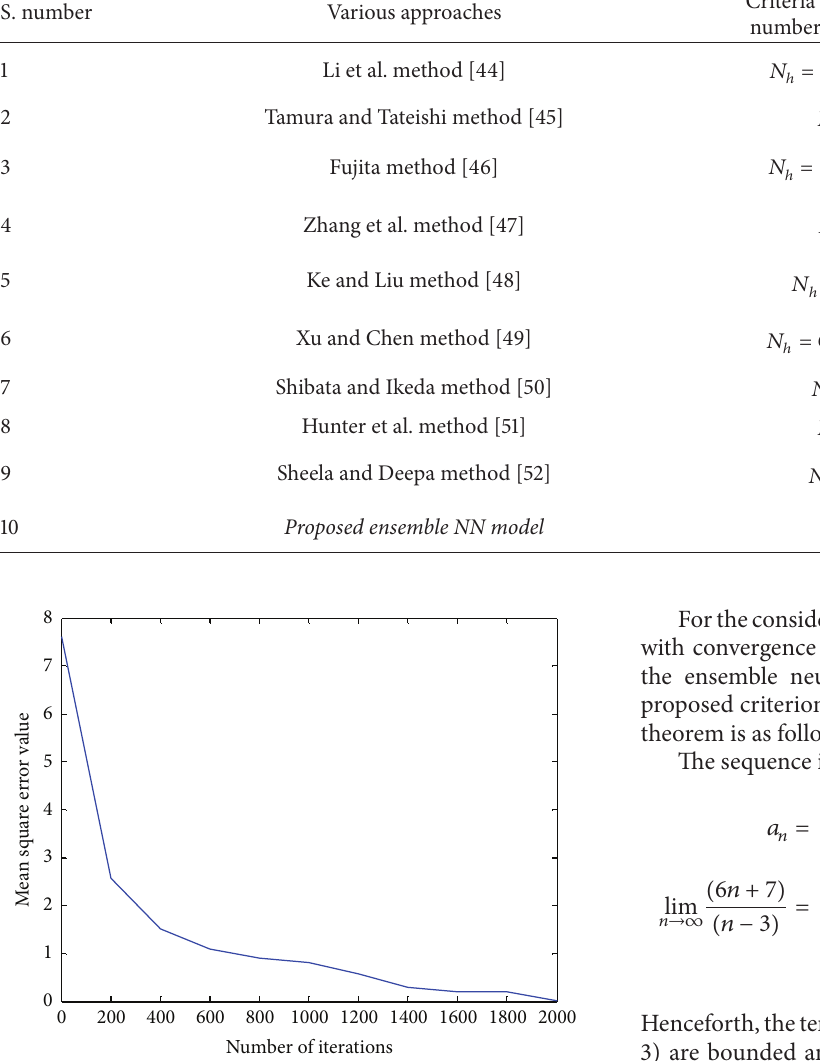
Figure 4: Computed MSE value using the proposed ensemble NN